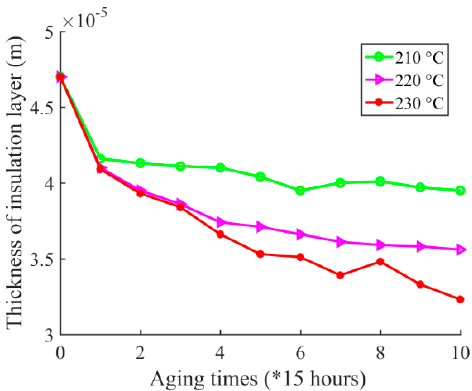
Figure 12. Magnet wire outer radius measurement results under 210 °C, 220 °C, and 230 °C.